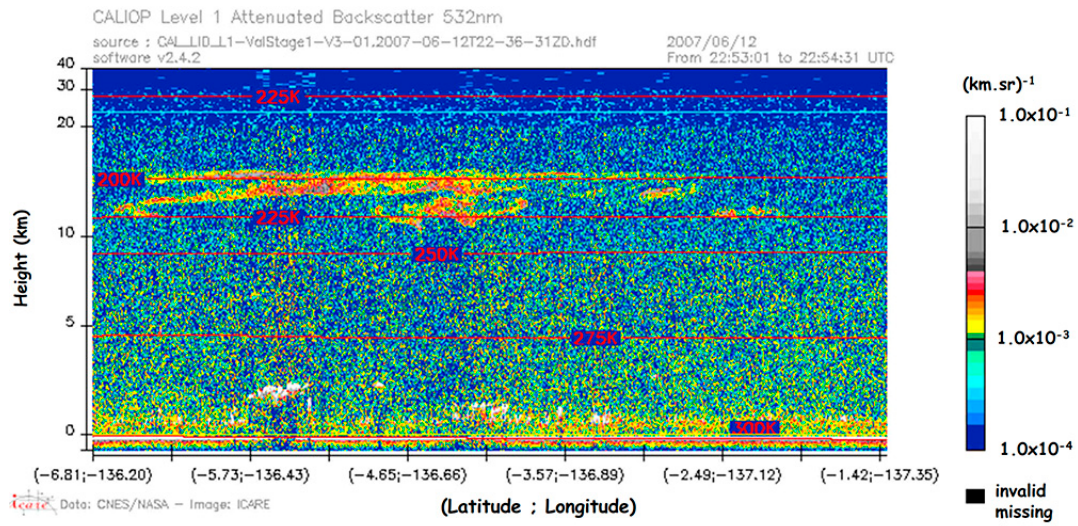
Figure 8. Cirrus anvil observed by CALIOP.